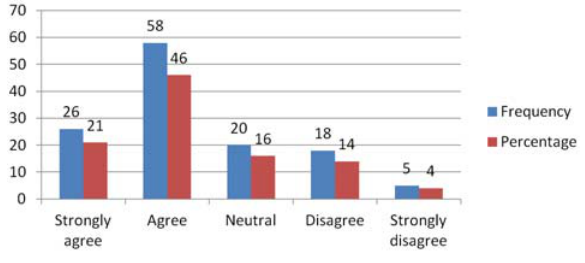
Fig. 2. Use of modern facilities